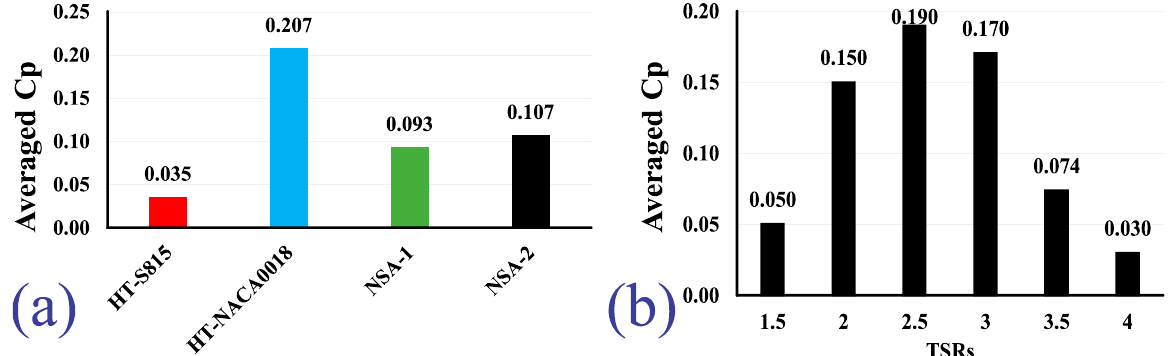
Figure 7. VAWT power coefficients vs. TSRs.